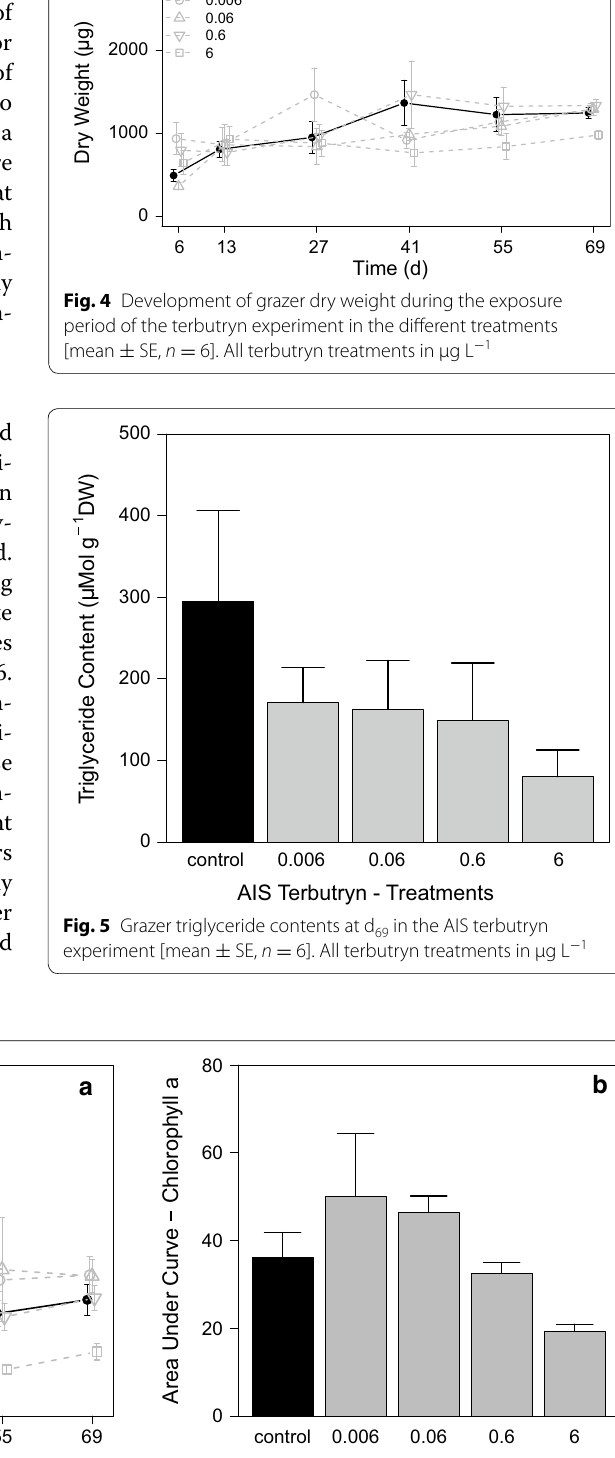
d 69 exposure period. b AUC of the chlorophyll a calculated over the entire experiment [mean −